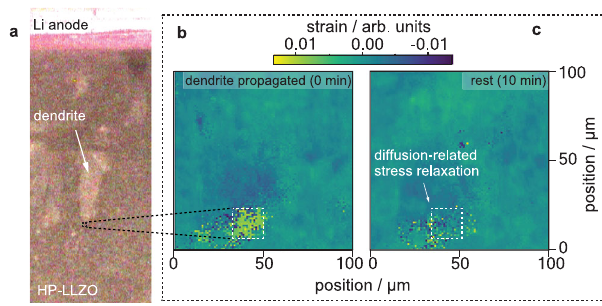
Fig. 5 | Operando microscopy and X-ray measurements of the Li metal and solid-state electrolyte. a The dendrite is highlighted in an optical microscope overviewimage,whilethemappedregionof10×10 µ mismarkedasablack-dashed square. The corresponding operando synchrotron X-ray nano diffraction strain maps show the region ahead of a Li dendrite directly after its growth and after a waitingtimeof~10min.Asinglegrainishighlightedandexhibitsadeviatoricstrain of ~0.0045( b , 0 min), and − 0.0015( c , 10min),equivalent toachange in deviatoric stress of ~750MPa. This relaxation was not detected when comparing the state during the dendrite ’ s growth and to the state directly thereafter. The grain is located ~8 – 10 µ m in front of the assumed dendrite